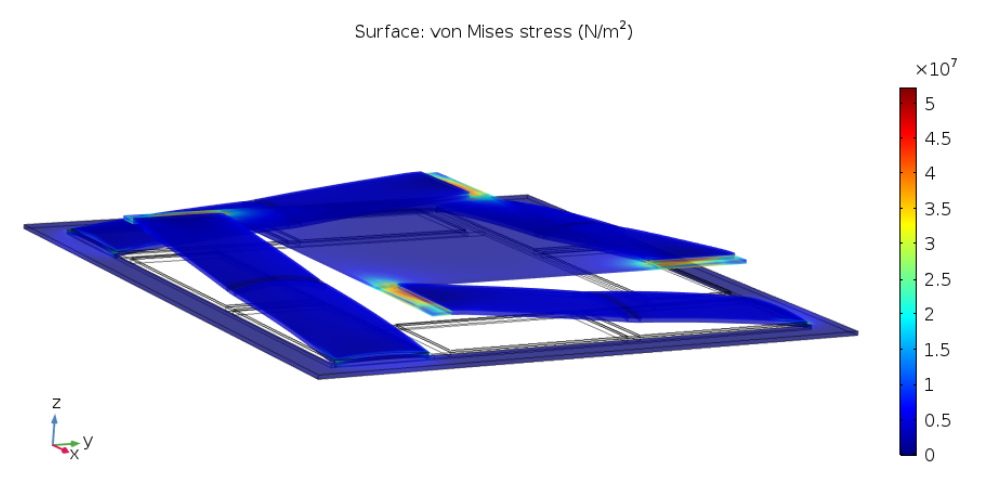
Figure 4. von Mises Stress in the joint connecting the end point of the cantilever actuator to the load. Red colour indicates regions of high stress. It is evident that the joints have become a potential weak point of the